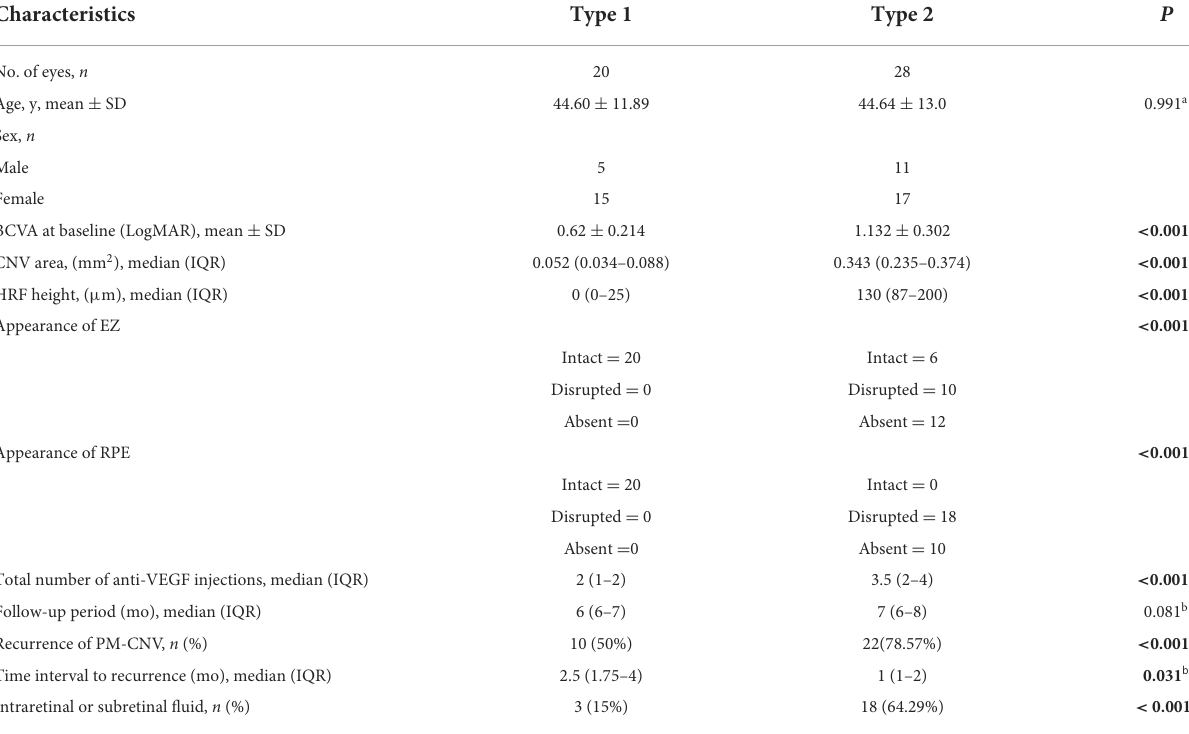
TABLE 2 Baseline demographic and clinical characteristics of patients with PM-CNV.